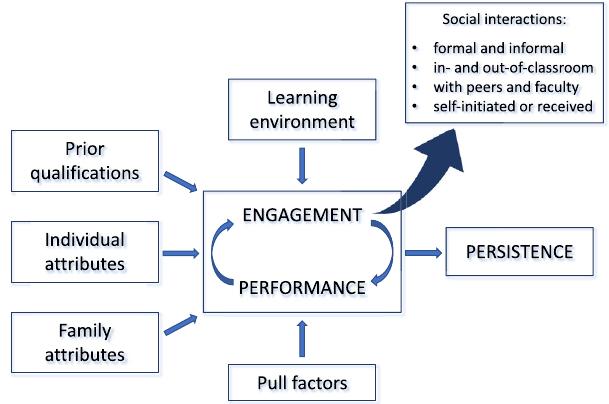
FIG. 1. A simplified conceptual schema of the theoretical framework combining elements from Tinto ’ s and Nora ’ s models used in this work